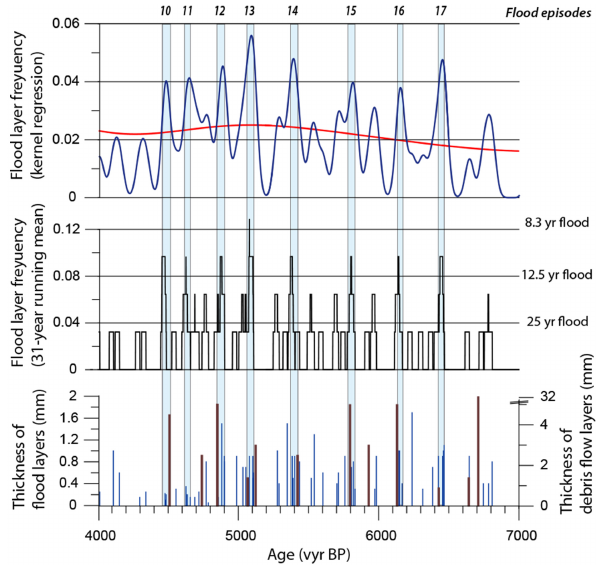
Fig. 5. Thickness of debris flow (detrital layer type 1) and flood lay- ers (detrital layer type 2). Flood layer frequency as calculated by a 31yr running mean and kernel regression with different bandwidths (blue line: 30yr, red line: 500yr). Eight main flood intervals (FE 10 to FE 17) are identified according to multi-decadal flood